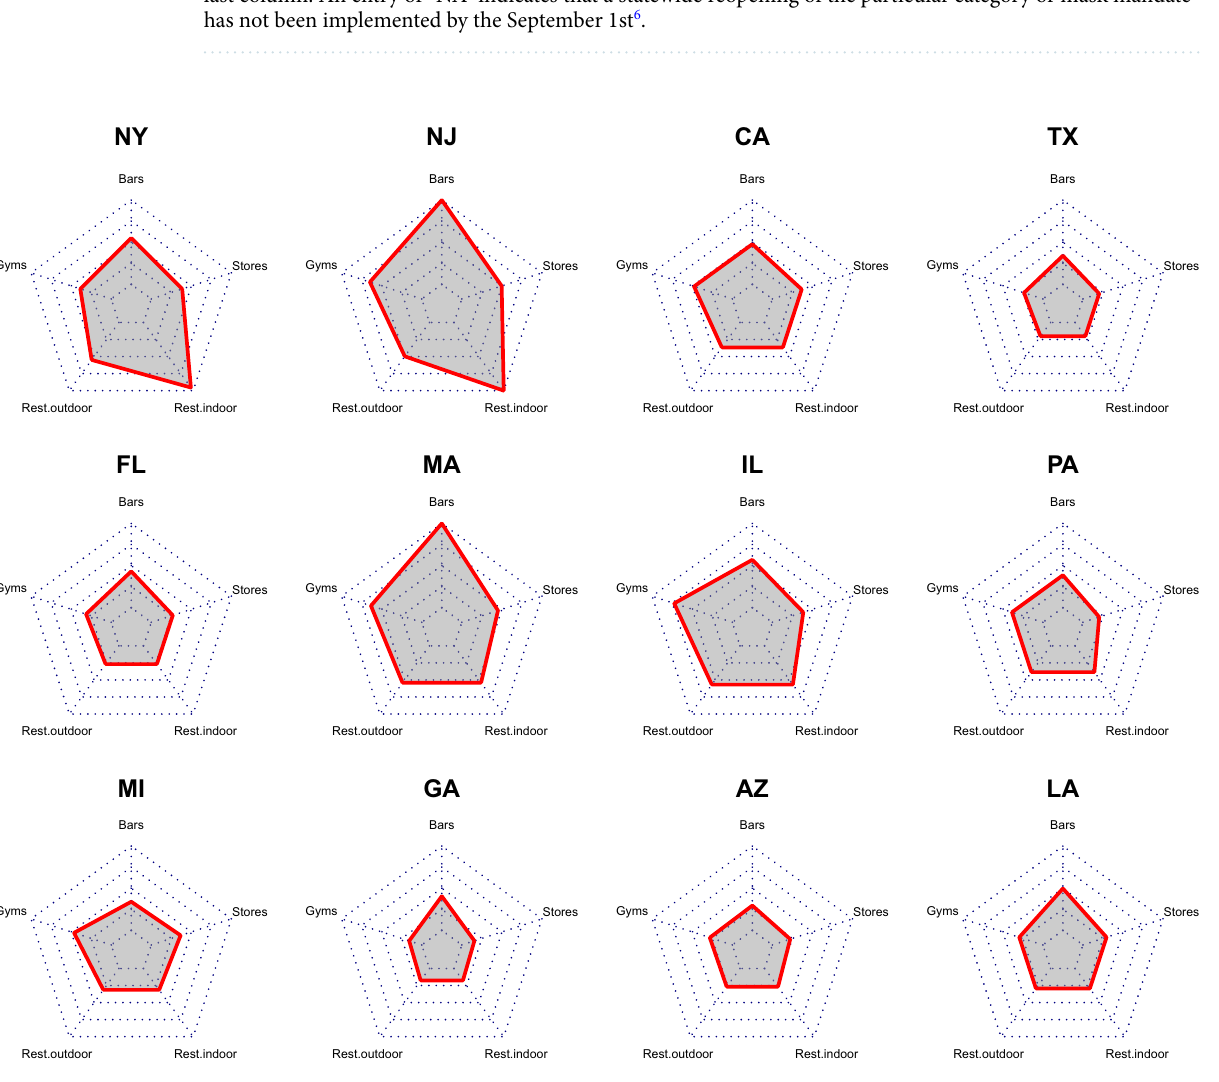
Figure 4. Radar charts for the reopening policies in different states. Five different categories are included: indoor restaurants, outdoor restaurants, gyms, bars, and stores. The earlier the reopening, the closer to the origin of the radar chart the vertex is. The zeroth day (origin of the radar chart) is April 1st, and the last day (the edge of the radar chart) is August 31st. A smaller pentagon implies a more aggressive approach in the reopening. The area does not necessarily imply a quantitative measure of the effect of reopening. It merely represents the dates of reopening of different categories of venues. Notes: The data can be found in Table